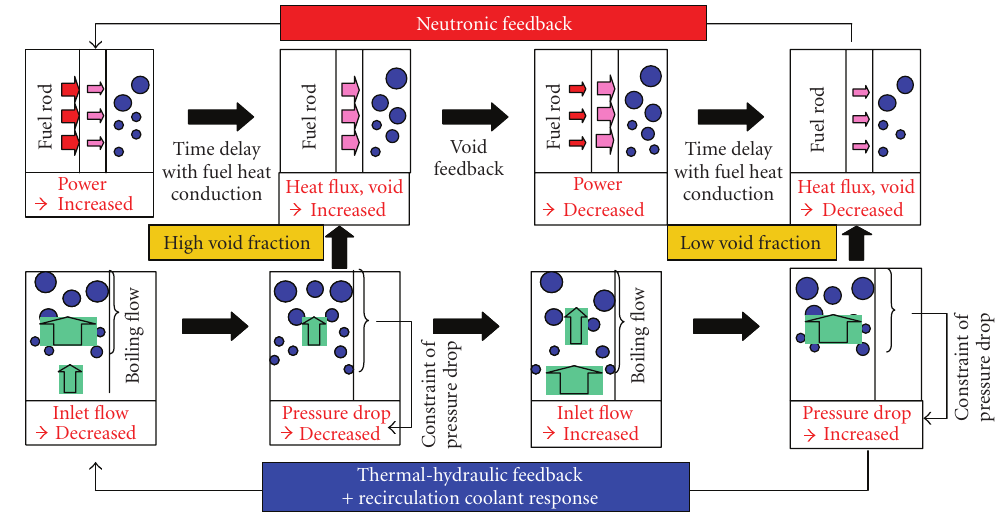
Figure 2: Schematic description for core instability mechanism.